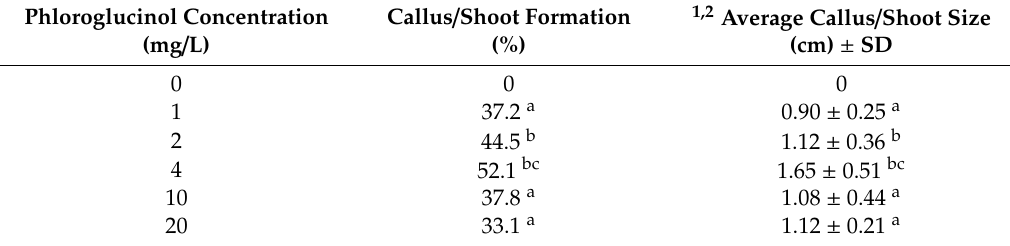
Table 3. Phloroglucinol e ff ects on tissue culture of young Ornithogalum dubium